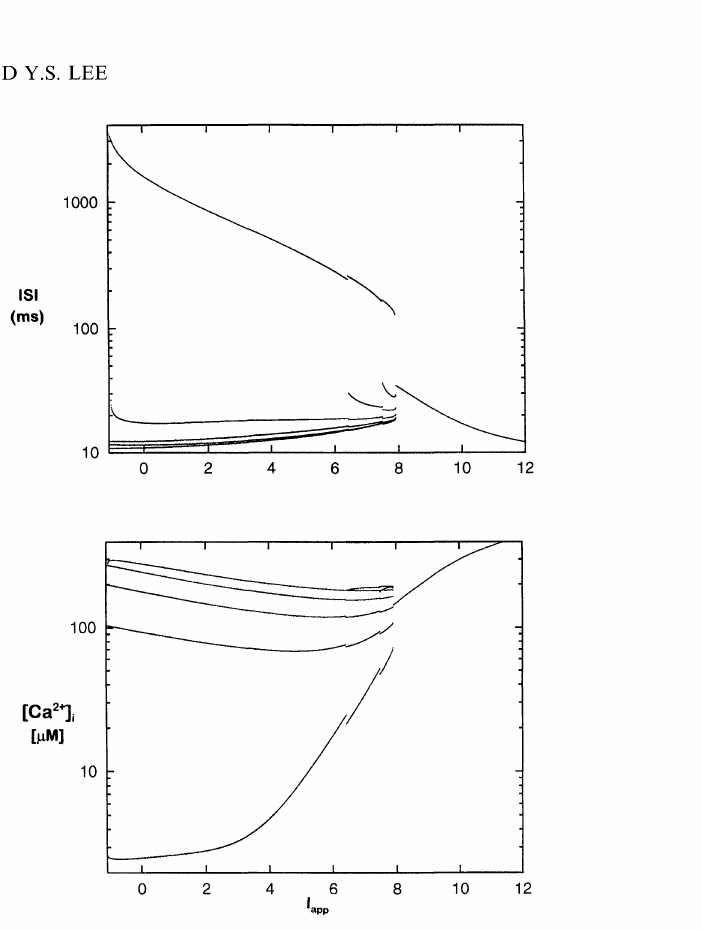
FIGURE 8 Bifurcation diagram for the pyramidal neuron showing the interspike interval (top) and [Ca2+]i (bottom) as a functions of I.pp. The ISI and [Ca2+]i were collected when- ever the upstroke of V passes -10inV. Note that the burst- ing period (the top line in ISI) decreases exponentially while the number of spikes remains almost constant (the number of spikes can be found from the number of lines in [Ca2+]i